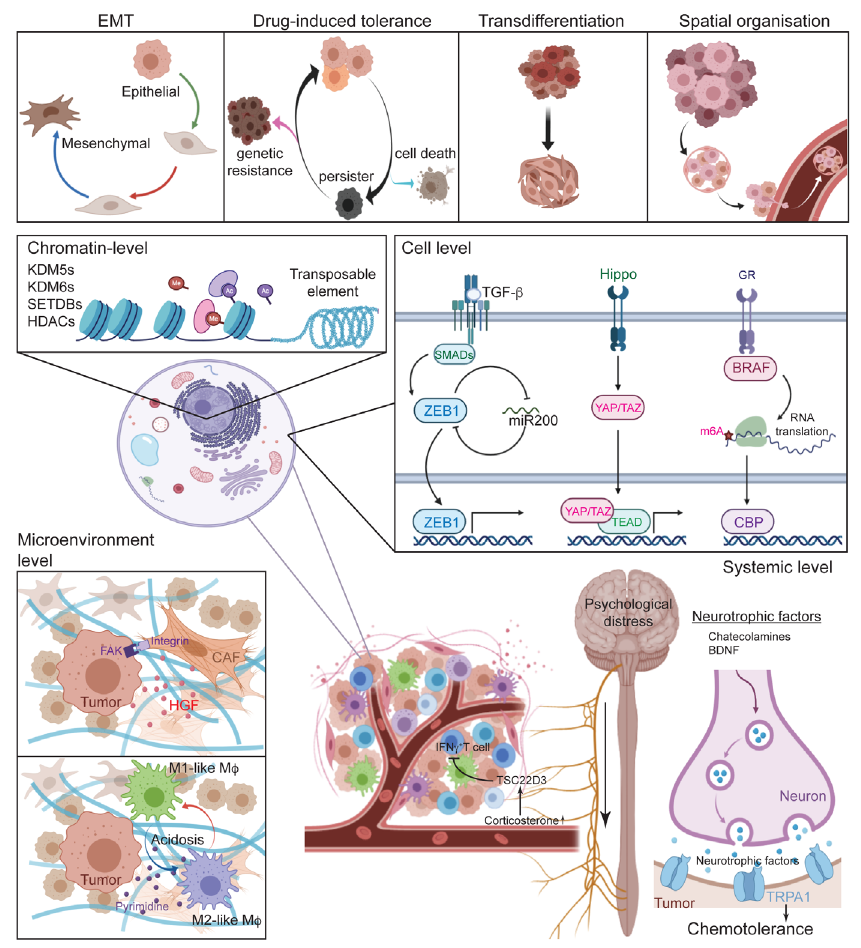
Figure 1. Summary of cell plasticity models. ( A ) Four scenarios of cell plasticity represent the current models and challenges. ( B – E ) Potential mechanisms of cell plasticity on different levels. ( B ) On the chromatin level, epigenetic regulators and DNA elements are shown to be involved in tumour cell tolerance to chemotherapy. ( C ) On the cellular level, intracellular signalling pathways sensing diverse environmental cues reprogram the transcriptional landscape, leading to adaptation to drug exposures. ( D ) On the microenvironmental level, inter-cellular communications build up a ‘safe haven’ by direct cell-to-cell interactions and by ‘quorum sensing’ mechanisms. ( E ) Psychological distress remotely controls tumour cell adaptation by secreting systemic neurotrophic factors. Ac, ; BDNF, Brain-derived neurotrophic factor; BRAF, Proto-Oncogene B-Raf; CAF, Cancer-associated fibroblast; CBP, CREB Binding Protein; EMT, Epithelial- to-Mesenchymal transition; FAK, Focal Adhesion Kinase; GR, Growth factor; HDAC, Histone deacetylases; HGF, Hepatocyte Growth Factor; IFN γ , Interferon gamma; KDM, Lysine demethylases; Me, Methylation; SETDB, SET Domain Bifurcated Histone Lysine Methyltransferase; SMAD, Mothers Against Decapentaplegic Homolog; TEAD, Transcriptional Enhancer Factor TEF; TGF- β , Transforming growth factor beta; TRPA1, Transient Receptor Potential Cation Channel Subfamily A Member 1; TSC22D3, Glucocorticoid-Induced Leucine Zipper Protein; YAP/TAZ, Yes Associated Protein/ Transcriptional Coactivator With PDZ-Binding Motif; ZEB1, Zinc Finger E-Box Binding Homeobox